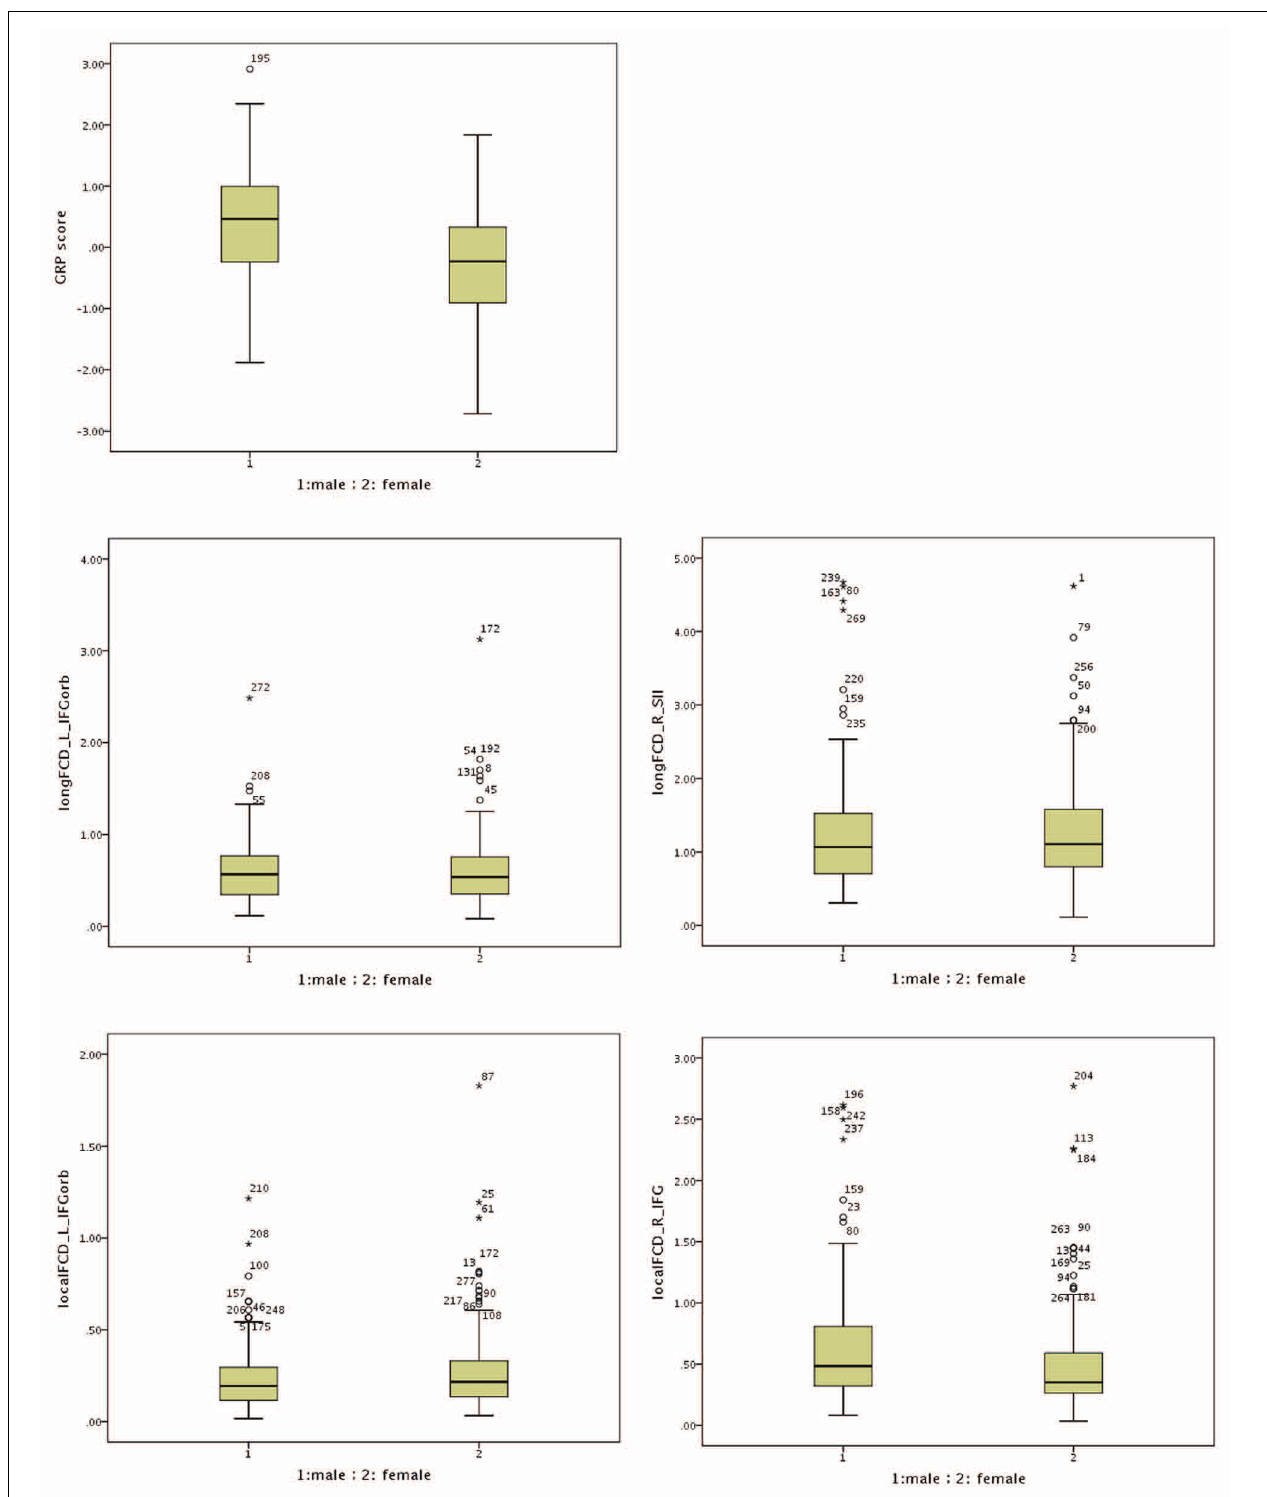
FIGURE A3 | Boxplots for the GRP score and the functional connectivity density (FCD) in males and females. Open dots indicate a mild outlier with scores more than 1.5 ∗ IQR from the rest of the